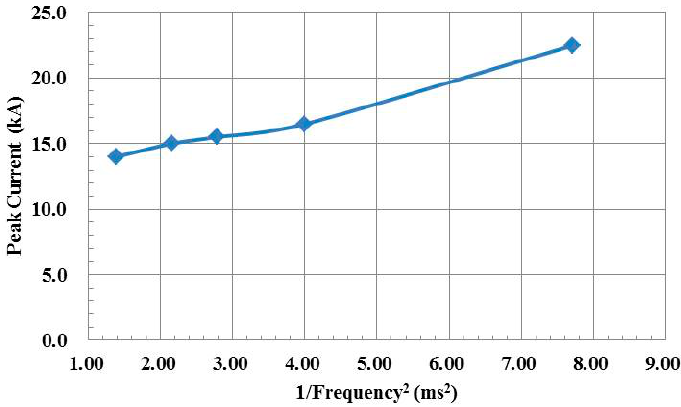
Figure 4. Relationship of limit interruption and frequency.